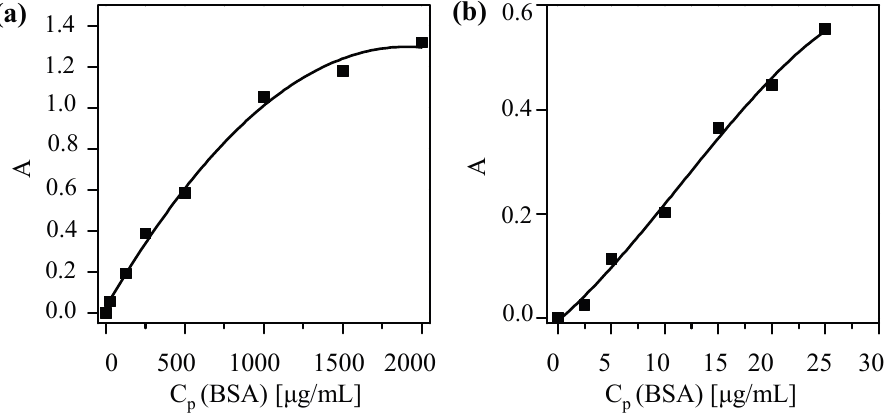
Figure 4. Coomassie assay calibration curves to determine the protein concentration C P of solutions with ( a ) high concentration and ( b ) low concentrations by measuring the offset-corrected absorption A at 595 nm. The fitting curves are ( a ) A ( C P ) = 0.029 + (0.001 mL/ μ g)· C P − (3 × 10 − 7 mL 2 / μ g 2 )· C P 2 , and ( b ) A ( C P ) = − 0.005 + (0.017 mL/ μ g)· C P – (6.789 × 10 − 4 mL 2 / μ g 2 )· C P 2 – (1.97 × 10 − 5 mL 3 / μ g 3 )· C P 3 and the coefficients of determination ( r 2 ) are equal to 0.994 and 0.989, respectively.